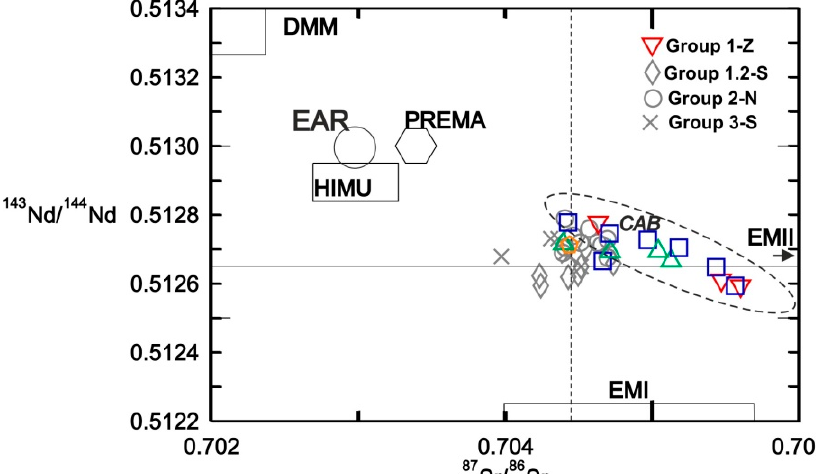
Figure 12. Isotopic characteristics of Bont ă u volcanic complex relative to the mantle components defined by [52] and the European Asthenospheric Reservoir (EAR) defined in [53,54]. Symbols and source of the data as in Figure 9. CAB defines the field of the calc-alkaline basalts in the Carpathian Pannonian Region after [22]. Data of the Groups 1-Z, 1.2-S, 2-N, and 3-S from [3].